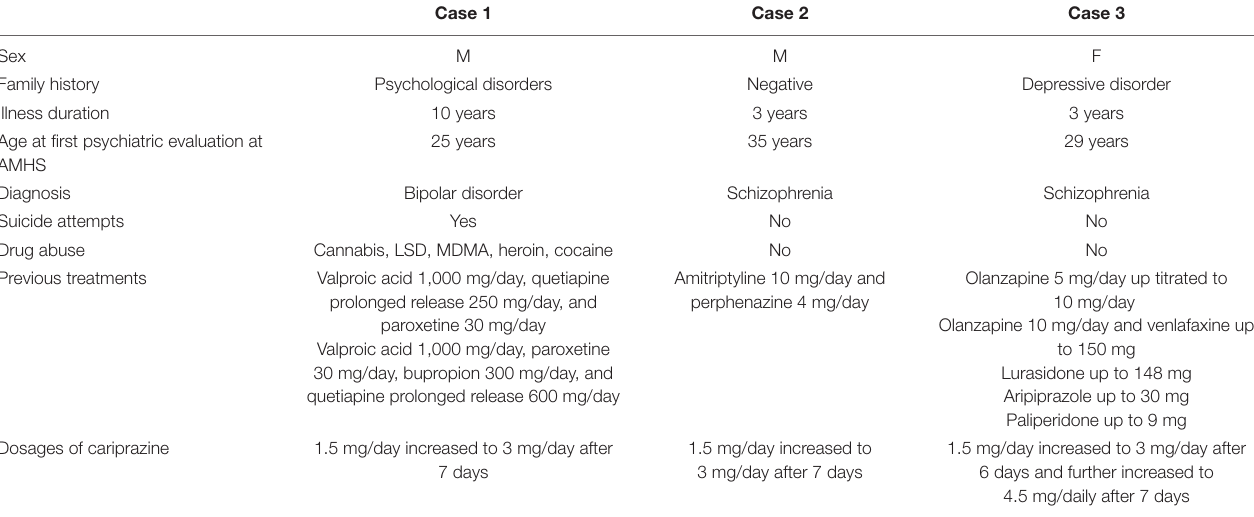
TABLE 3 | Summary and comparison of the clinical